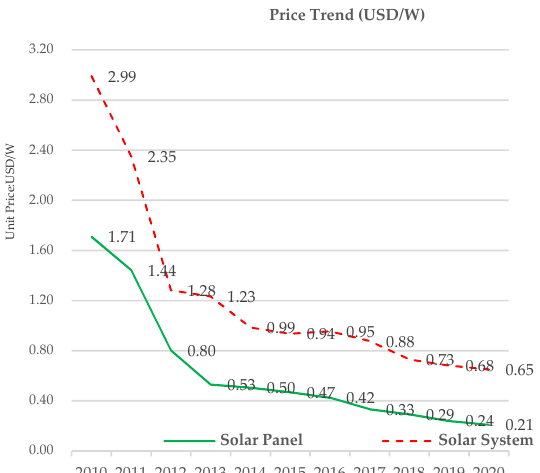
Figure 4. Cost reduction trend of solar panels and solar project. Source: the author.